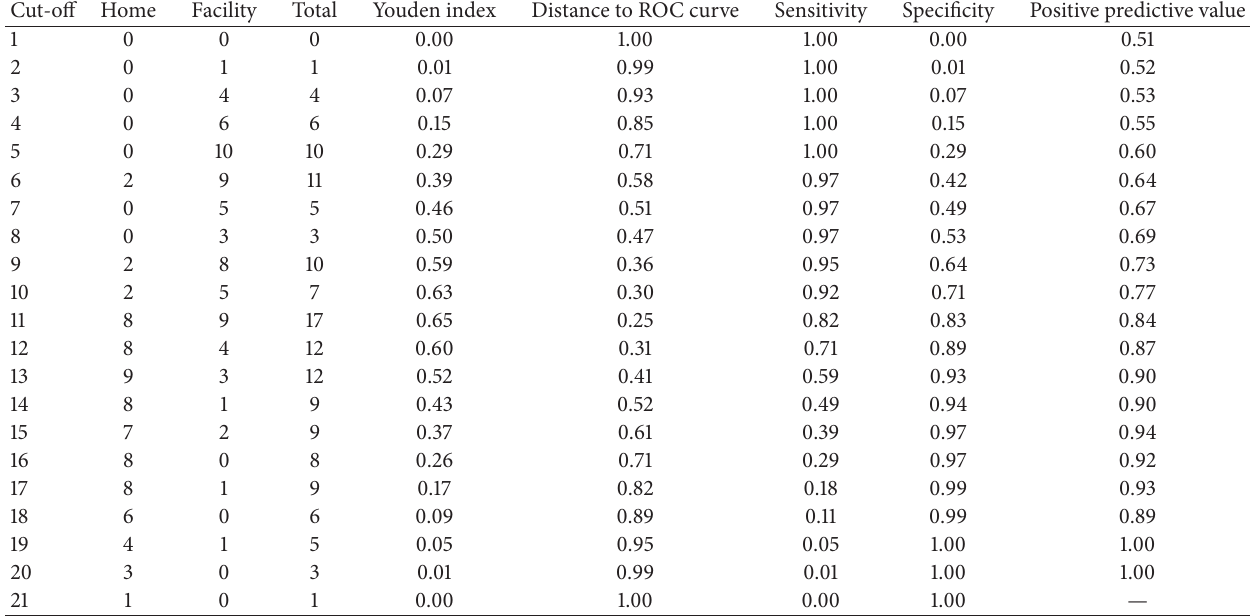
Table 2: Receiver operating characteristic (ROC) curve analysis of the home care score (HCS) to determine the most appropriate cut-off score.